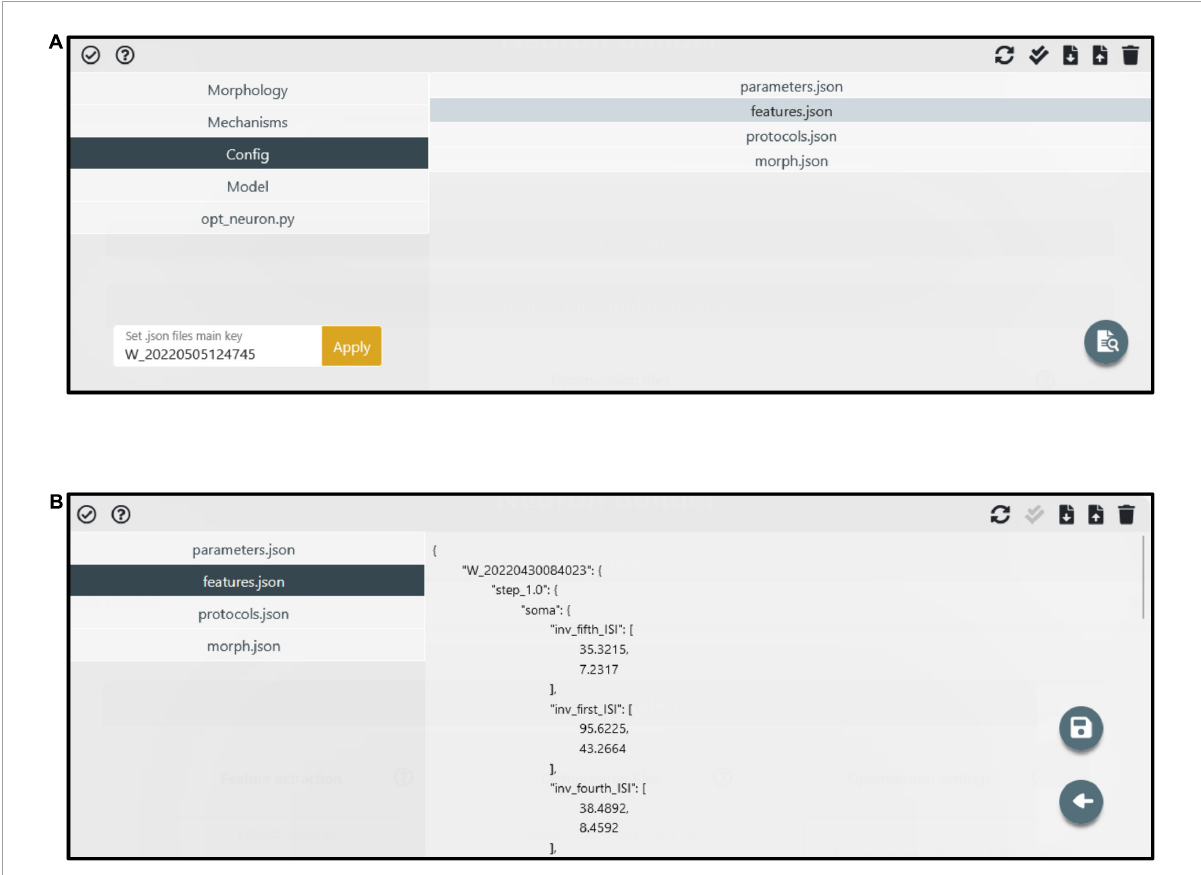
FIGURE4 Manage files panel. (A) The model components (i.e., files and folders) are accessible through the left menu. The folder content is visible in the right panel after a folder is selected. Via the top-right buttons, users can upload, download, delete and update the folder content. Via the bottom-right button, specific files (e.g., the feature extraction result files) can be edited. (B) An example of a file (i.e., features.json ) in edit mode. A dedicated button (i.e., the floppy disk icon) allows to save the modified